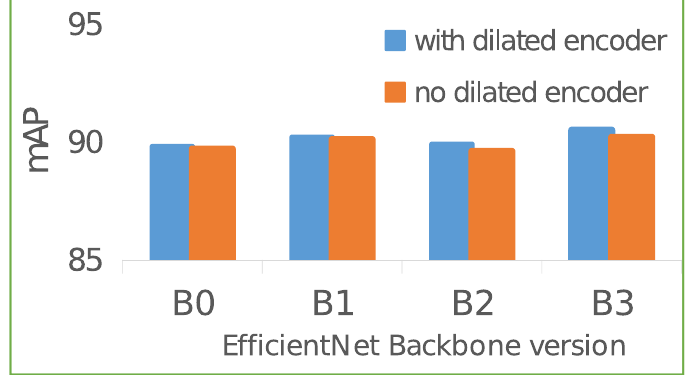
Figure 1. ’BN‘ denotes that the backbone network used is EfficientNet-BN. We perform a thorough experimental analysis on the TE-YOLOF examining whether the dilated encoder can help in the blood cell detection on the blood cell detection BCCD dataset. This figure shows the performance comparison of the model on mAP with or without the dilated encoder module when replacing different backbones of TE-YOLOF. The metric of mAP represents that the mean Average Precision of each category with the Intersection Over Union (IoU) threshold of